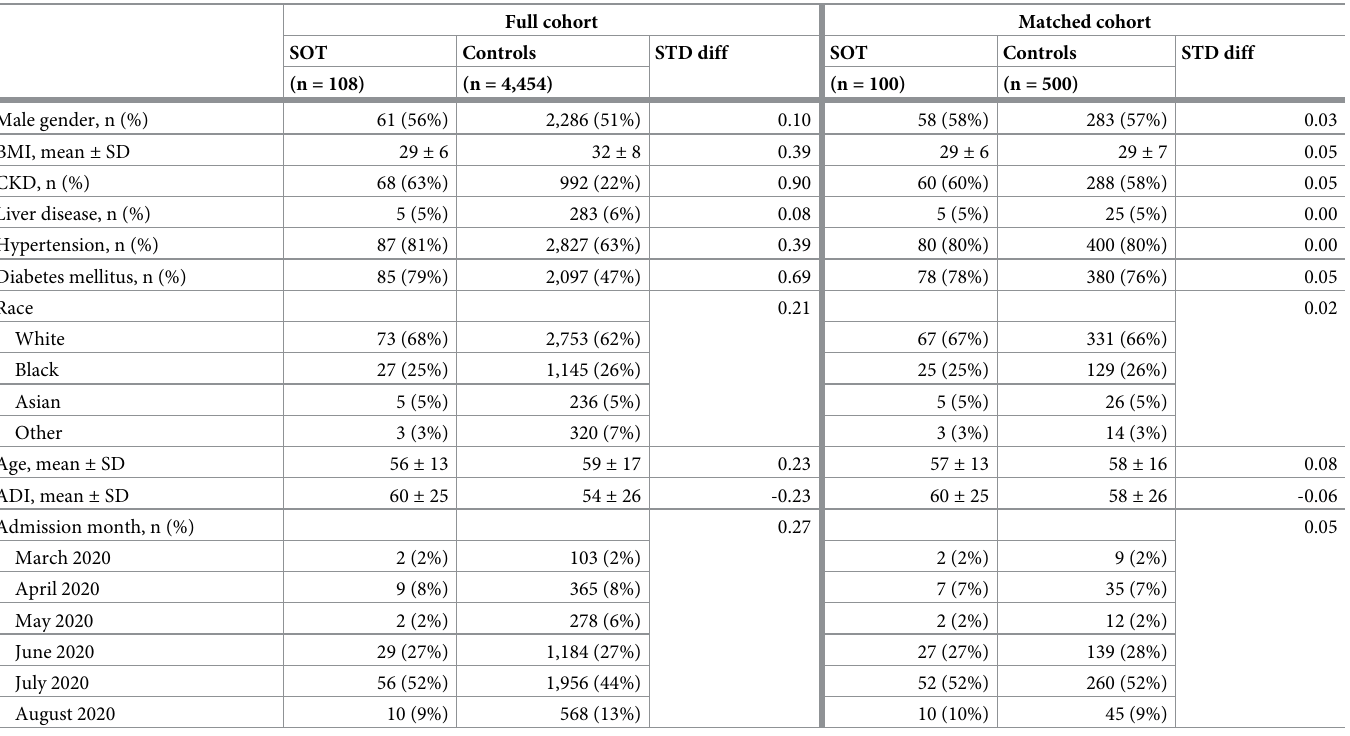
Table 2. Balance of covariates before and after